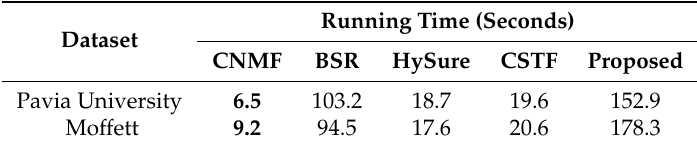
Table 5. Running time (in seconds) comparison of fusion algorithms (the boldface numbers denote the best